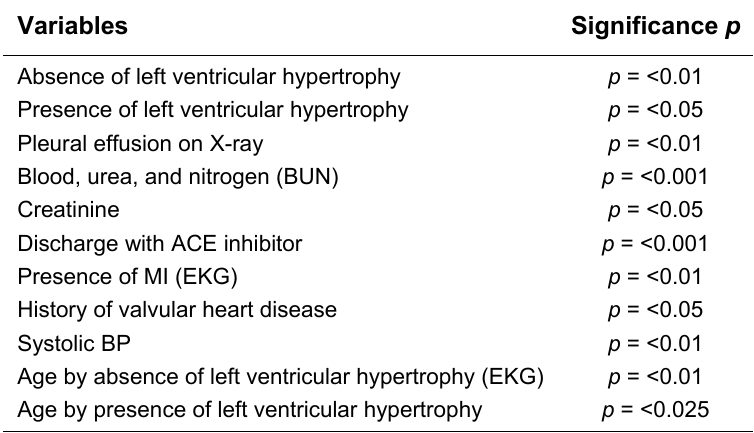
Significant Variables: Neural Network Models — 90